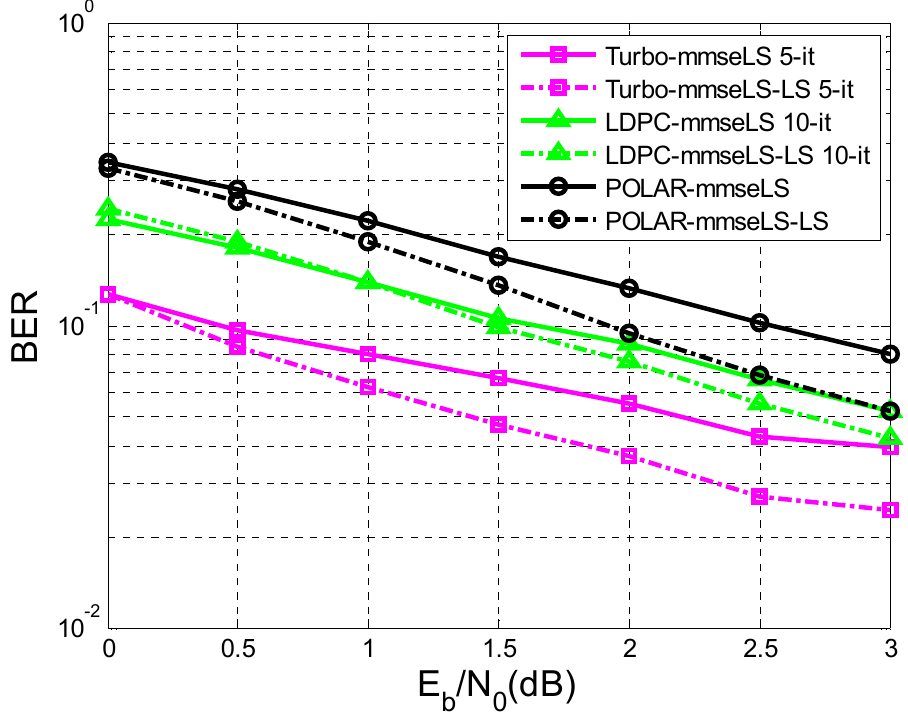
Figure 16. BER vs. SNR for different codes in the case of MMSE equalization applying iterative LS estimation (K = 342 bits h = (0.18 0.85 0.32), N = 8).